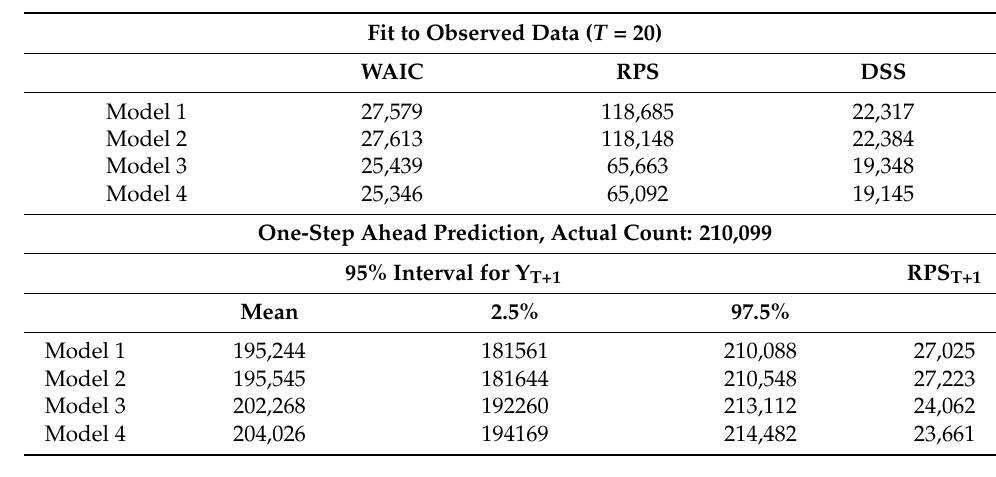
Table 4. Ranked Probability Score (RPS) (Posterior Means by Week and